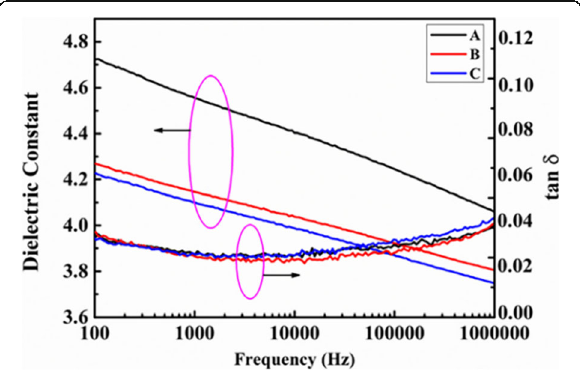
Fig. 1 The dielectric constant and dielectric loss of different molecular weight ArPTU films (A, B, and C are polythioureas synthesized by the molar ratio PDTC/MDA (1/1), PDTC/MDA (0.95/1), and PDTC/MDA